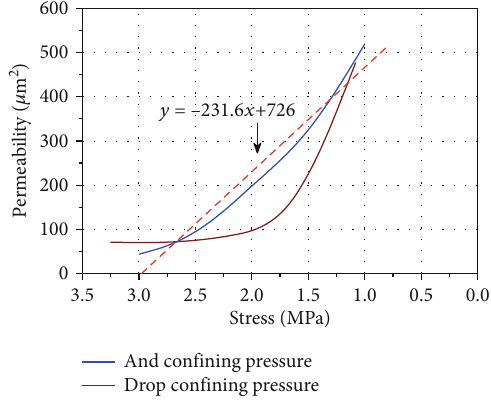
Figure 14: Permeability change curve of coal specimen under loading and unloading con fi ning